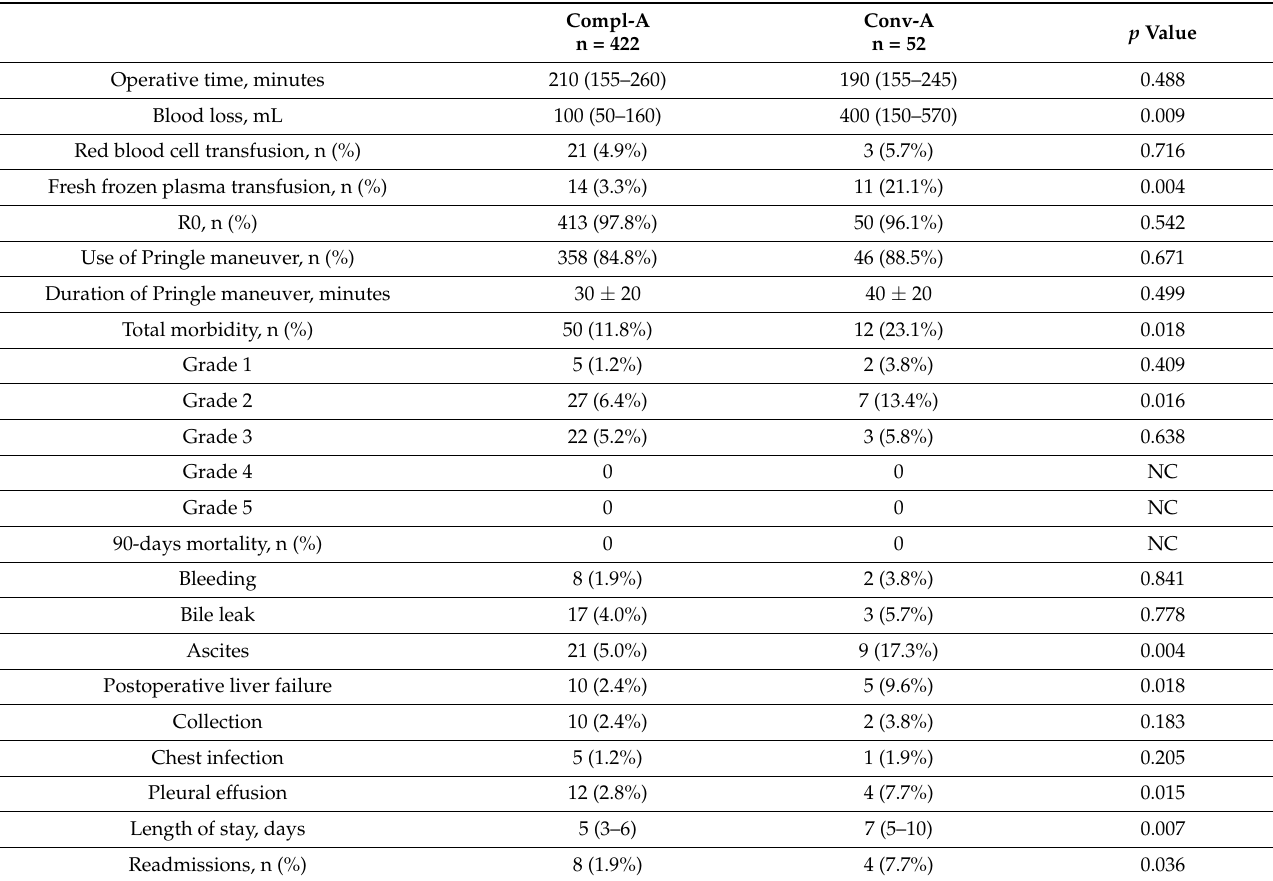
Table 3. Results of completed versus converted MILRs for HCC in Child A patients without portal